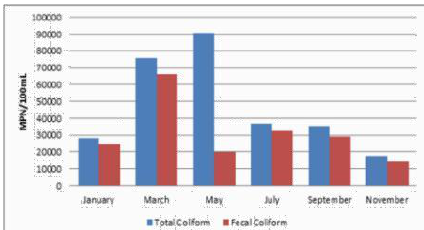
Figure 2. Total and Fecal Coliform Monitoring Results of the Drainage Outfall, CY